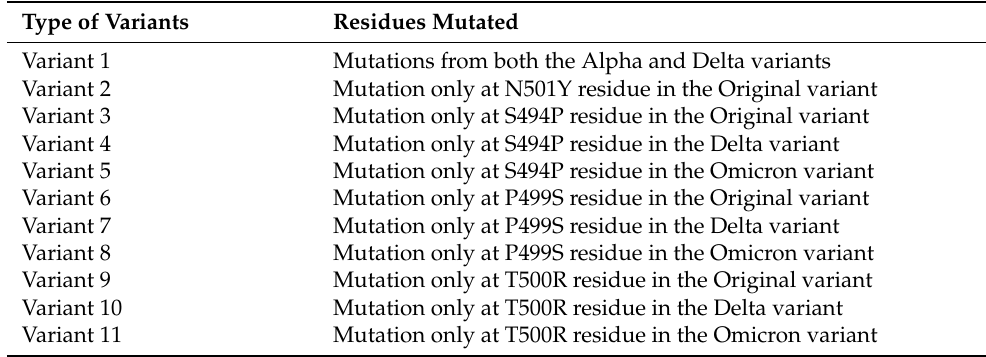
Table 2. Artificially generated variants with their residues mutated that do not naturally exist as a pathogenic